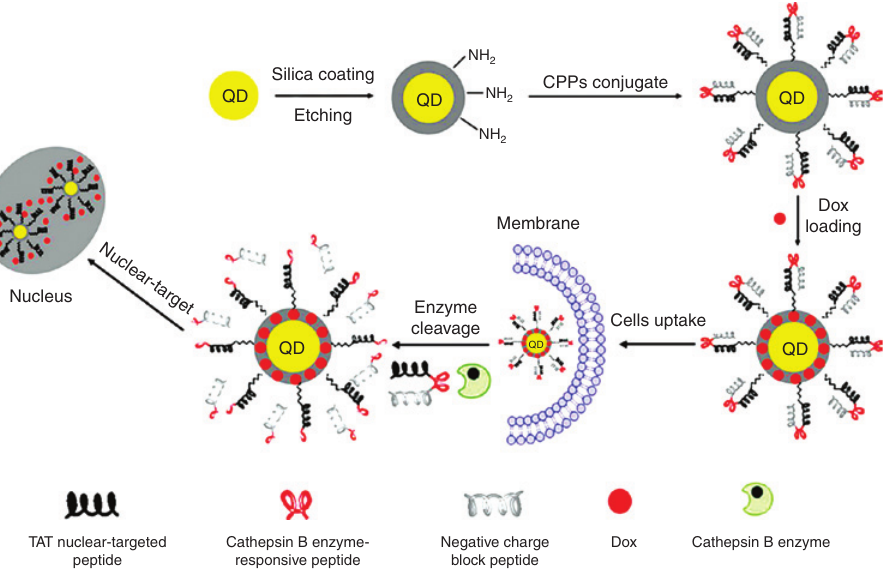
Figure 3: Schematic mechanism of nucleus-targeted drug delivery; MSN was synthesized by quantum dot method and TAT sequence along with cathepsin B-responsive peptide attached to its surface. Inside the cancer cell, the enzyme cuts the responsive peptide, and the nucleus-penetrating agent guided the carrier to the nucleus. Reused from Reference [59] with the permission of John Wiley and Sons’